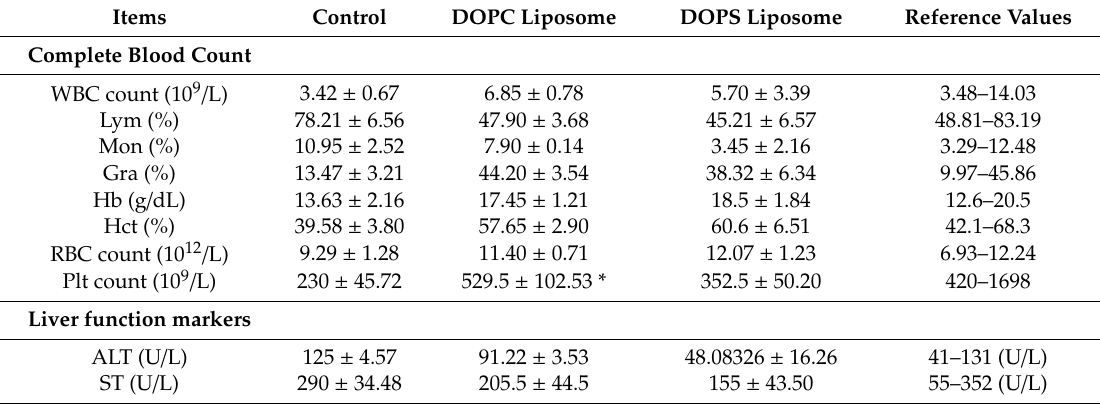
Table 4. In vivo toxicity assessment of complete blood count and liver function assays of belinostat free drug and loaded liposome system in balbc mice after subcutaneous administration in balb / c mice at 0.333 mg / g